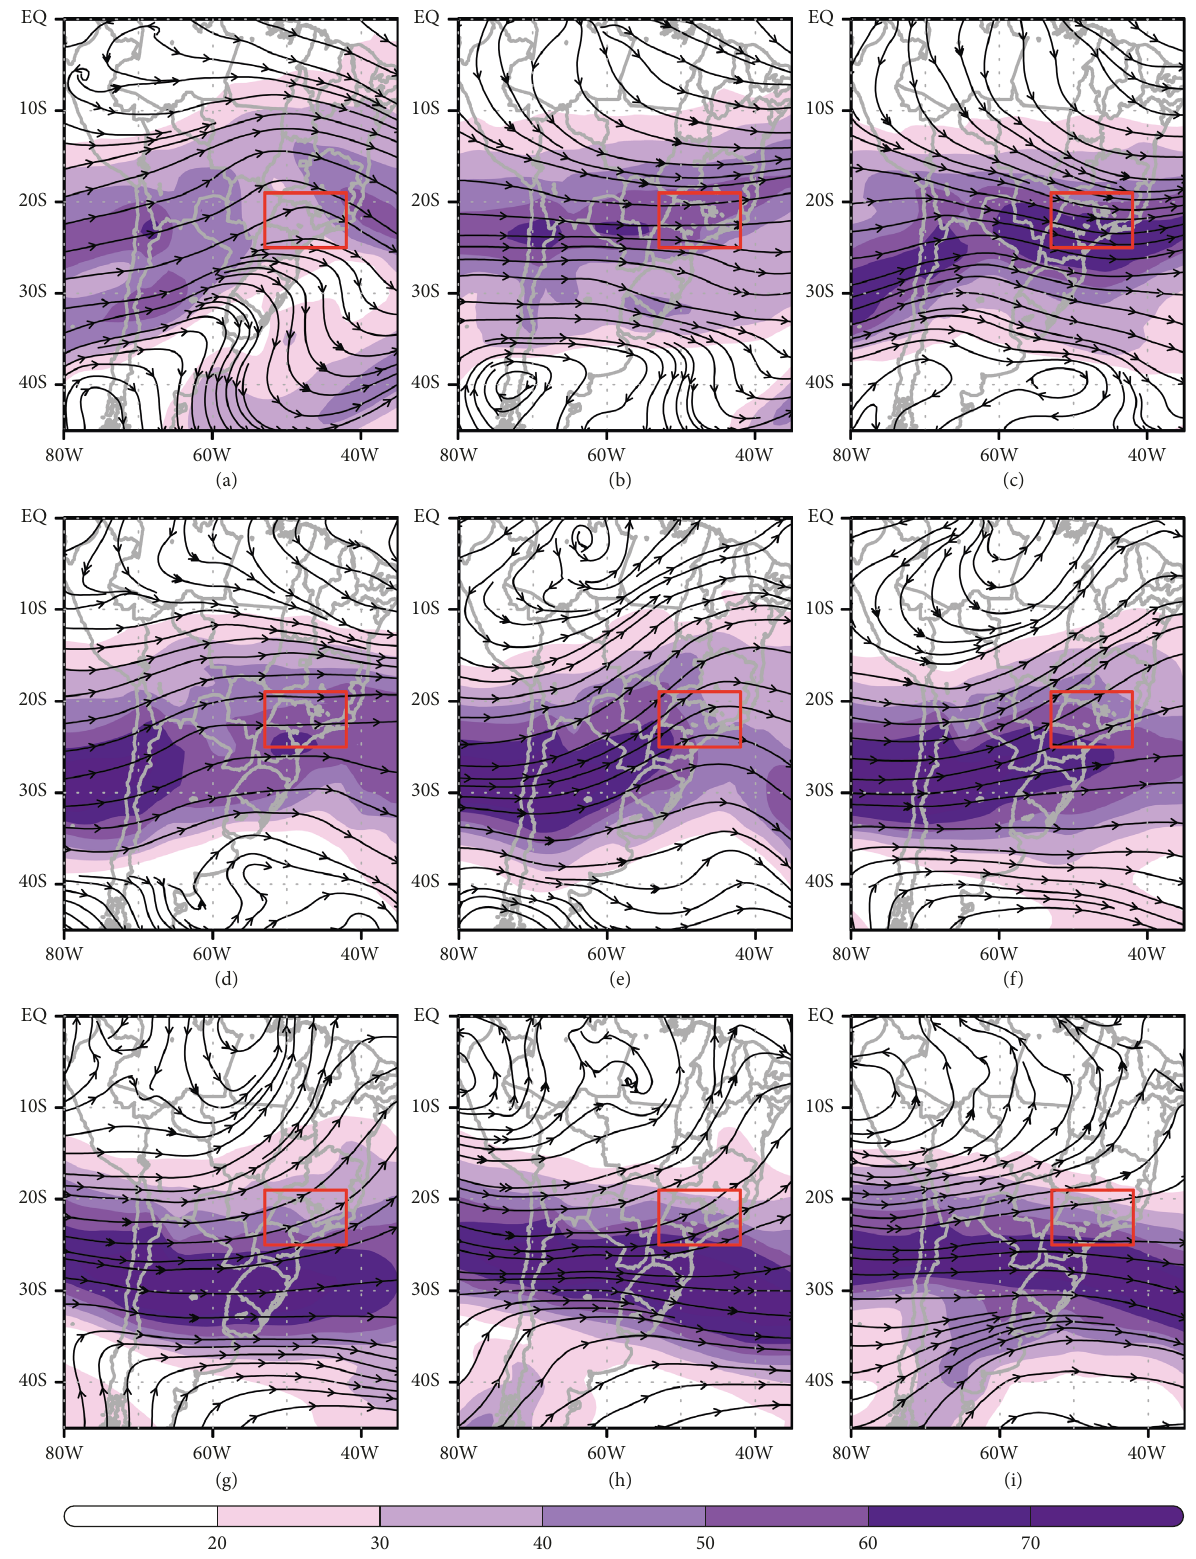
1 ) at 12 UTC on (a) 30 May, (b) 31 May, (c) 01 June, (d) 02 June, (e) 03 June, (f) 04 s · −